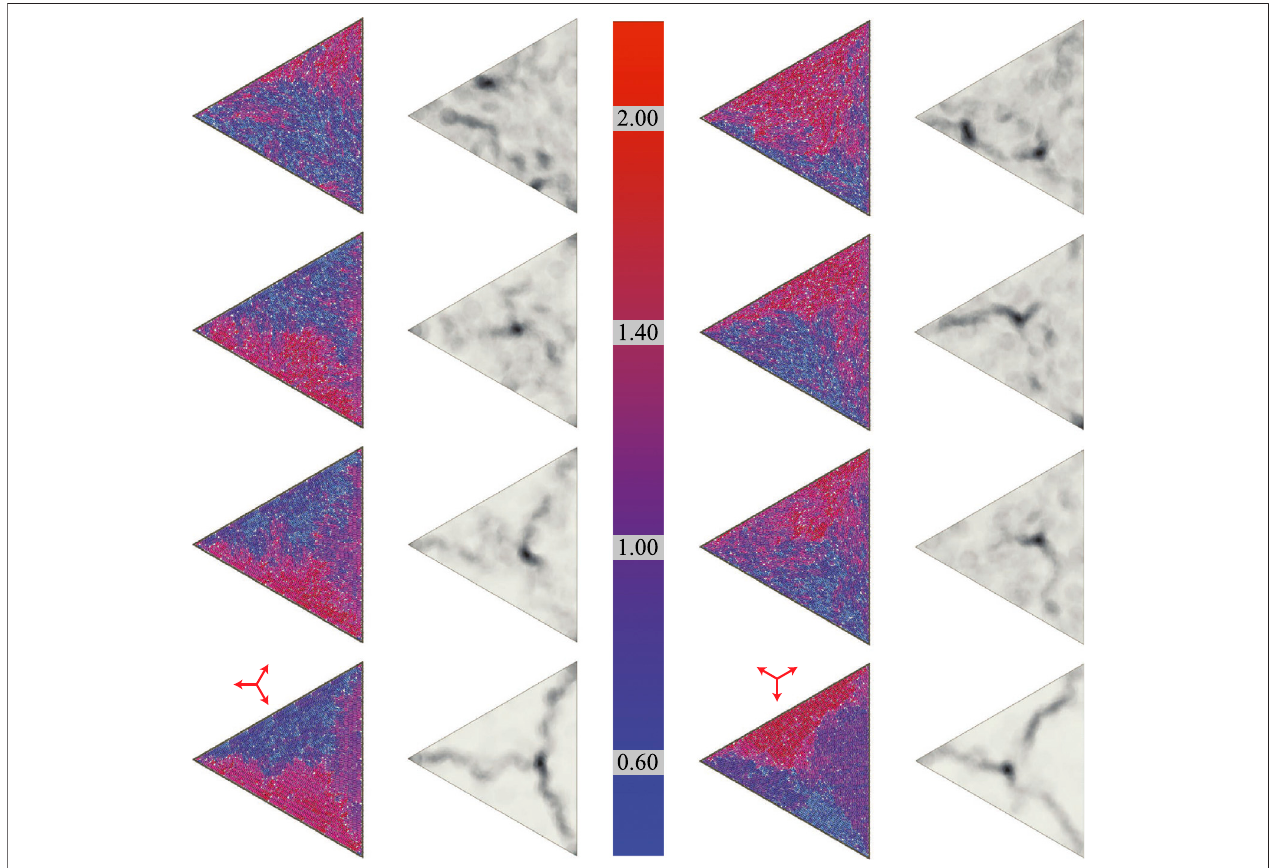
FIGURE 9 | The 2D GB ( 3 , 5 , 2 , 1 ) mesogen system con fi ned by a triangular boundary. Data are arranged as in Figure 7 . A set of approximate local directors highlighted for the lowest temperature (red arrows) enables differentiating between the two anchoring modes, as discussed in the main text.